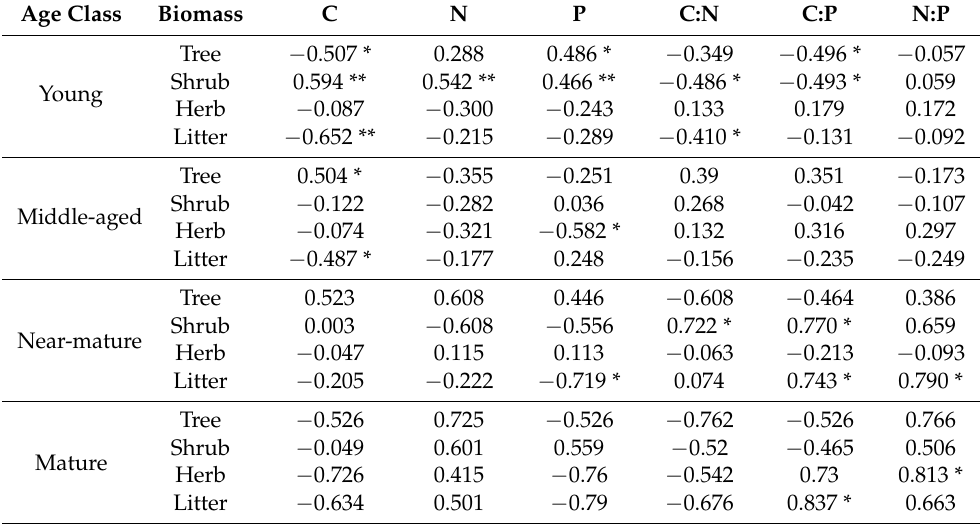
Table 6. Relationships between biomass of different layers and C, N, and P stoichiometry in tree, shrub, herb leaves and litter among different age